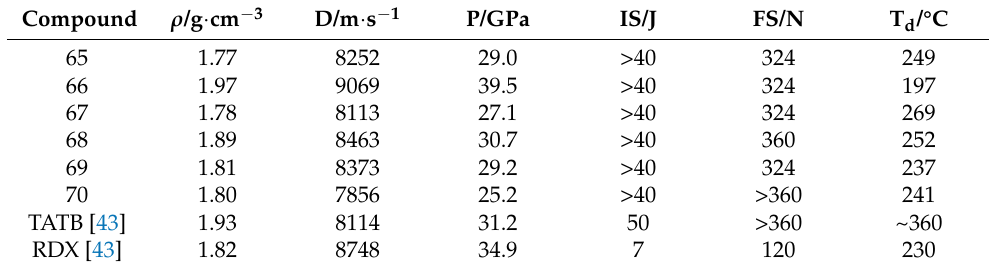
Table 1. Physiochemical properties and detonation parameters of energetic salts 65 – 70